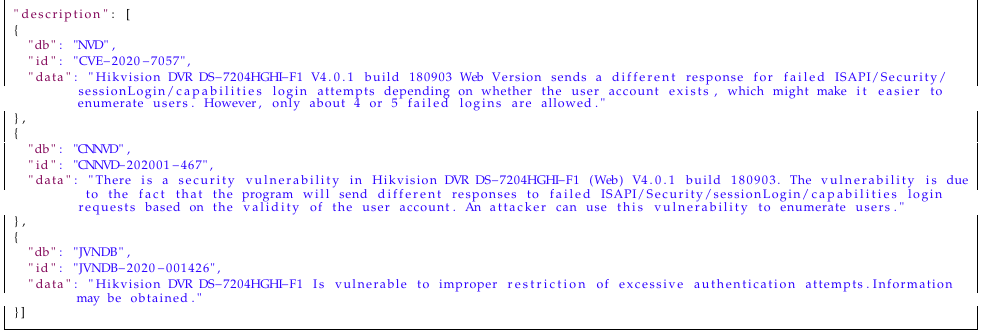
Listing 2. Example of the description field from the medium database entry.